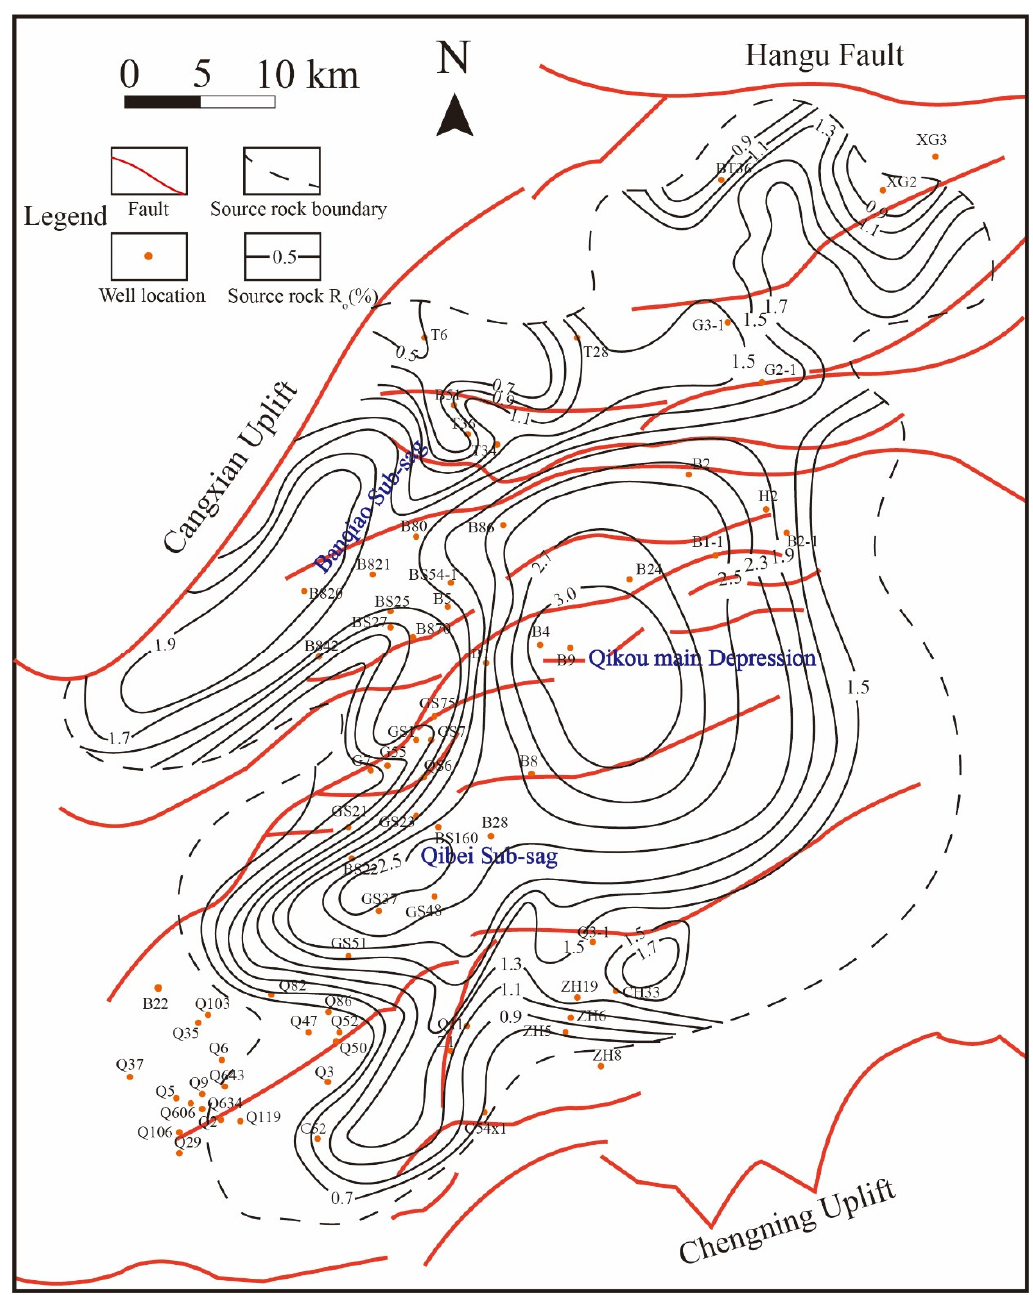
Figure 7. Mbr 3 source rocks’ R o characteristics.